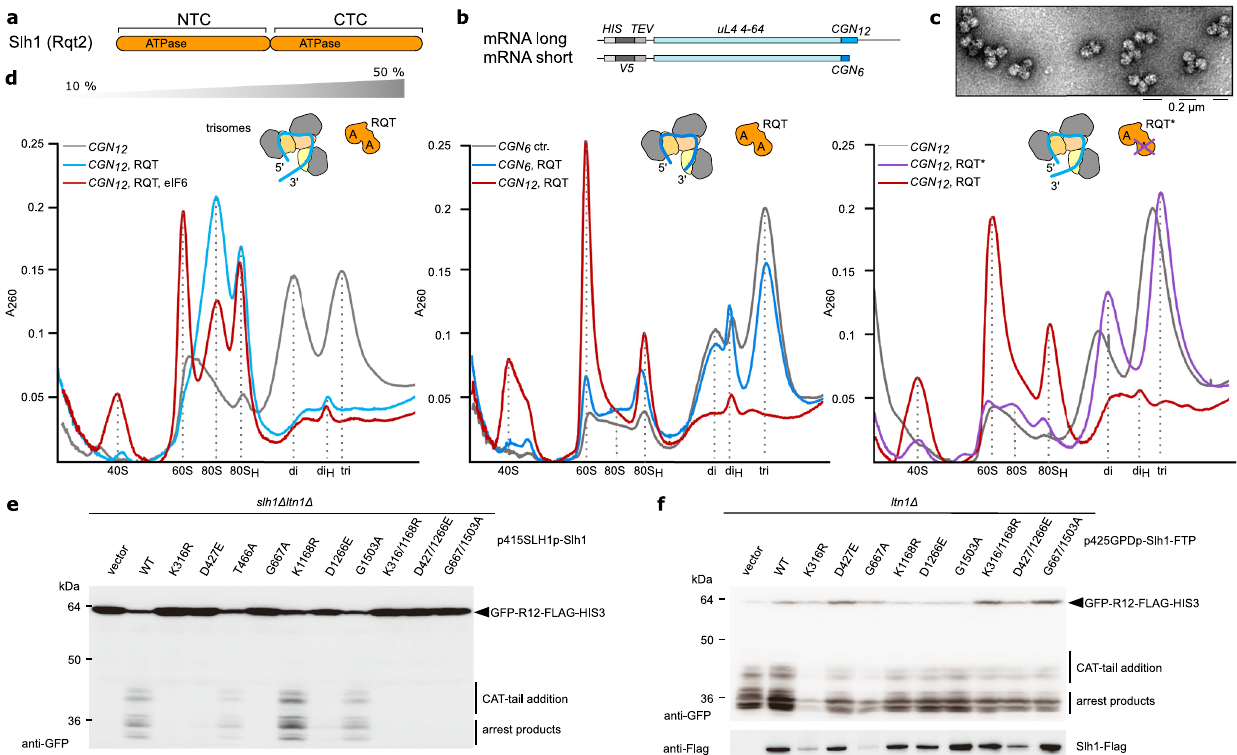
Fig.1 |BiochemicalanalysisofRQT-dependentsplitting ofcollidedribosomes. a Scheme outlining the tandem ATPase cassettes of Rqt2 (Slh1). NTC, CTC=N- terminalandC-terminalcassette. b SchemeoutliningthemRNAconstructsusedfor generating ubiquitinated trisomes. CGN 6 and CGN 12 =stalling mRNA sequence containing 6 or 12 consecutive CGN (N=A, G or C) codons. The constructs further encode N-terminal hexahistidine (HIS) and V5 epitope (V5) tags, a Tobacco Etch Virusprotease(TEV)cleavagesiteandatruncatedversionofribosomalproteinuL4 (uL4). c Representative uranyl-actetate stained negative stain-TEM image of poly- ubiquitinated trisomes. We obtained the same results for all (>5) trisome pre- parations. d Polyribosome pro fi les from sucrose density gradients obtained after in vitro splitting reactions. Left: Splitting reactions using trisomes with a long 3 ′ - mRNAstretchemergingfrom themRNAentrysite of theleadribosome(stalledon CGN 12 mRNA) and of RQT with intact helicase activity (see cartoon representation;